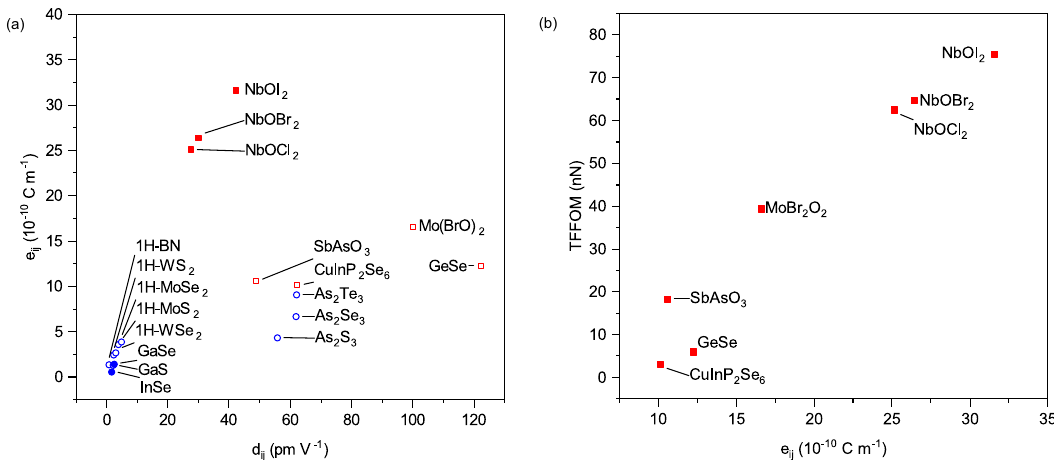
Fig. 3 Thin fi lm fi gure of merit (TFFOM) and spontaneous polarizations. a Plot of maximum sheet piezoelectric stress tensor elements ( e ij ) and corresponding piezoelectric strain tensor elements ( d ij ) for various 2D materials. For additional notes on GeSe, please see Supplementary Table S1. b Plot of TFFOM and maximum e ij of materials highlighted in Fig. 2 a . In a , solid symbols denote materials that are piezoelectric in the thermodynamically most stable bulk form, as documented in the Materials Project database 1 ; hollow symbols denote those that are not. Blue dots denote data points obtained from other studies 17,23,26,29,49 listed in Supplementary Table S2. Our computed e ij values for these materials are also provided in Supplementary Table S2 for comparison.